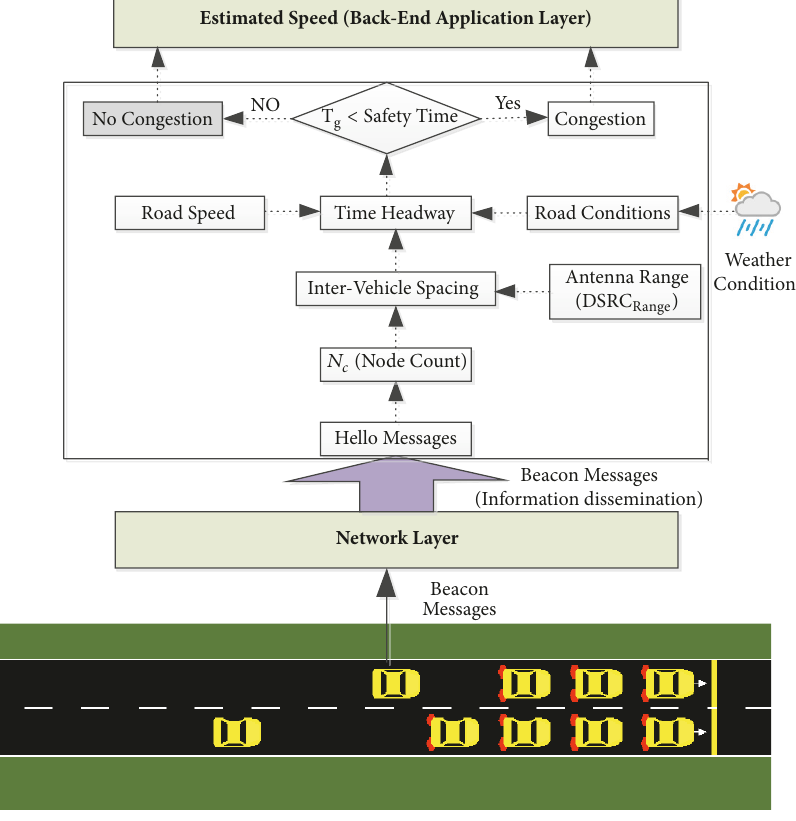
Figure 1: The work flow illustration of the